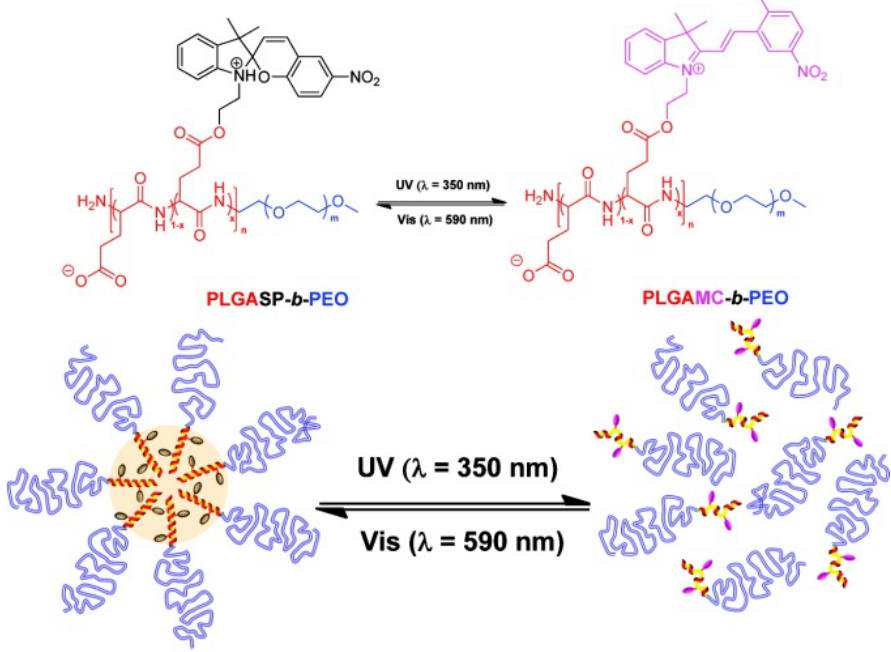
Scheme XII. Schematic illustration of photoresponsive micellization/dissolution process for the PLGASP- b -PEO block copolymer. Reprinted with permission from [80]. Copyright (2011) American Chemical Society.